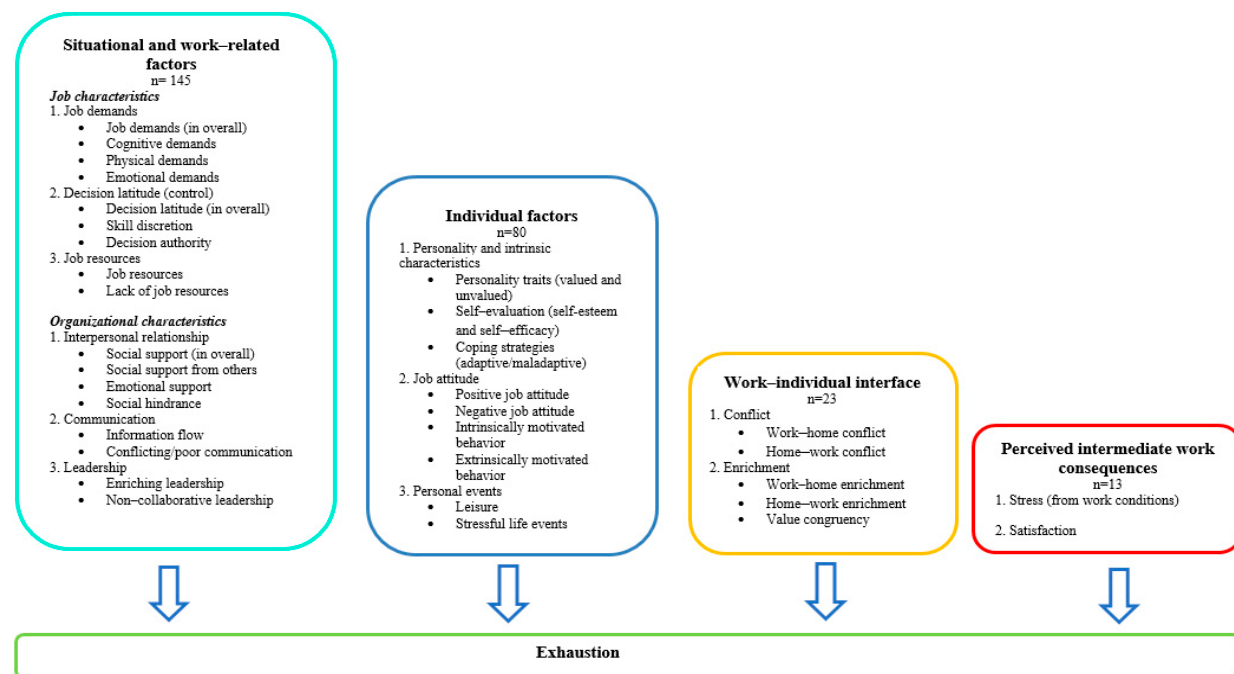
Figure 3. Description of predictor’s families and subfamilies.